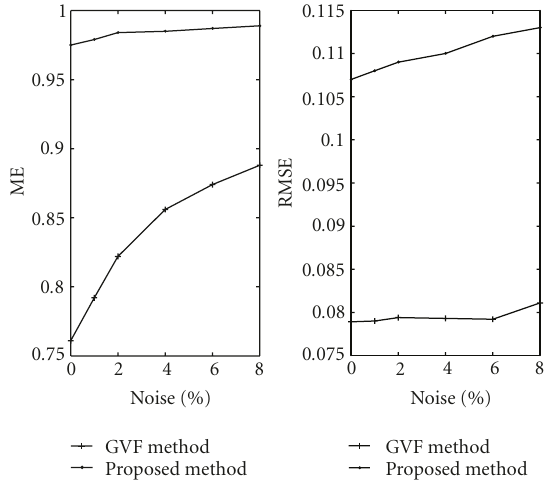
Figure 11: Mean value (pixels) and root mean square error (pixels), as a function of the percentage of noisy pixels, of the mean pixel bias value over the